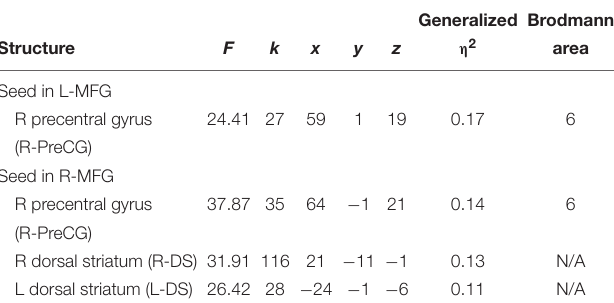
TABLE 3 | Generalized psychophysiological interaction analyses on functional connectivity with clusters of Relative Closeness-related